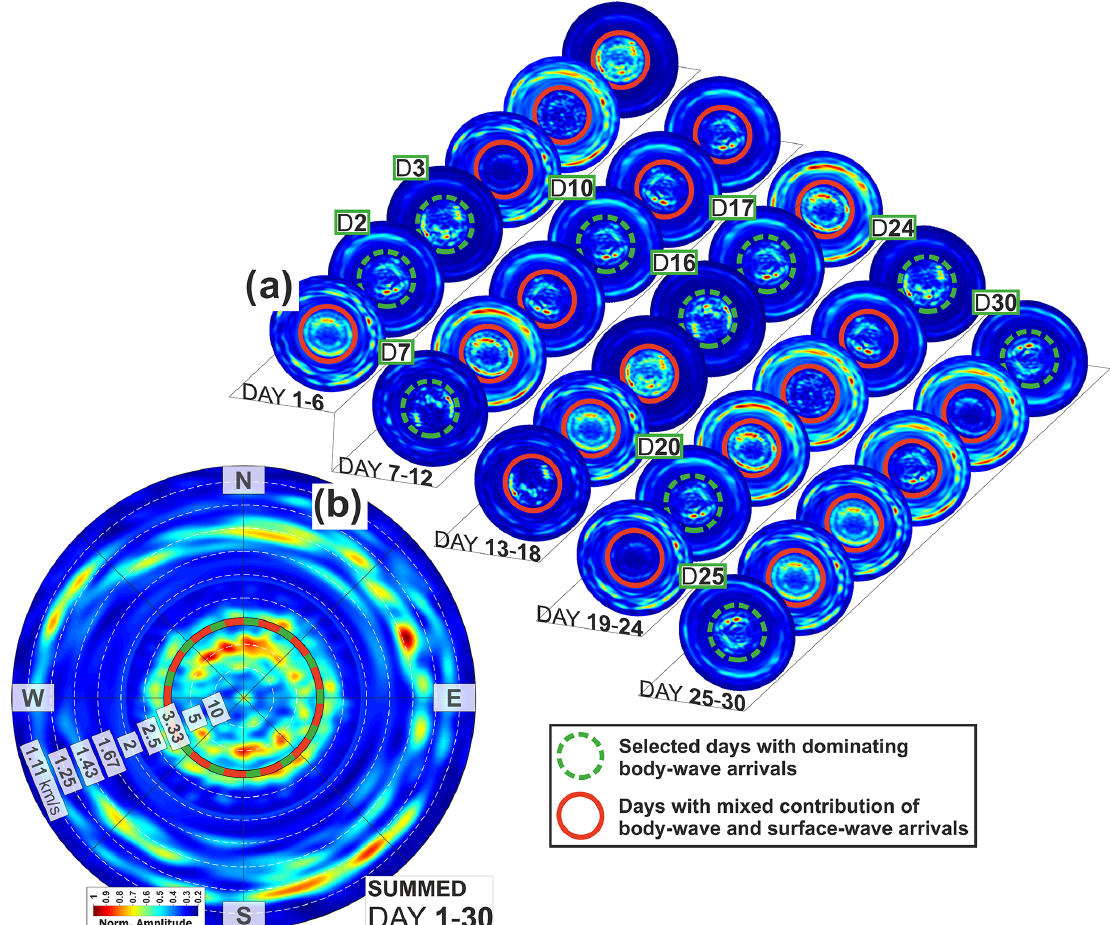
Figure 4. Directional beamforming analysis of recorded ambient noise (AN) using all available Kylylahti recordings. (a) Beamforming outputs calculated for 20 hourly panels from 30d of recording time. Each panel in (a) represents analysis for 1d of recording. Panels are displayed in chronological order. (b) Summed output of the results shown in (a) . Maximum values from each hourly (a) and daily (b) result are displayed as a function of apparent velocity and azimuth for the frequency range 3–5Hz. The north direction (N) has an azimuth of 0 ◦ . The azimuth increases to the west (i.e., counterclockwise), and apparent velocities increase toward the center of the circles. Warmer colors indicate directions of strong incoming energy. Green dashed circles in (a) highlight 10 daily AN recordings dominated by arrivals with apparent velocities > 4 . 8kms − 1 and used for initial selection of the 10d subset as the representation of the selective stacking approach in this study. In Sect. 4.2, this initial subset of data denoted with green circles in (a) is evaluated by TWEED to confirm that the AN recordings associated with apparent velocities > 4 . 8kms − 1 are related to body-wave events and eventually used to obtain the selectively stacked virtual-source gathers shown in Figs. 6 and 7 described in Sect. 4.3. The same days are highlighted with green arrows in Fig.